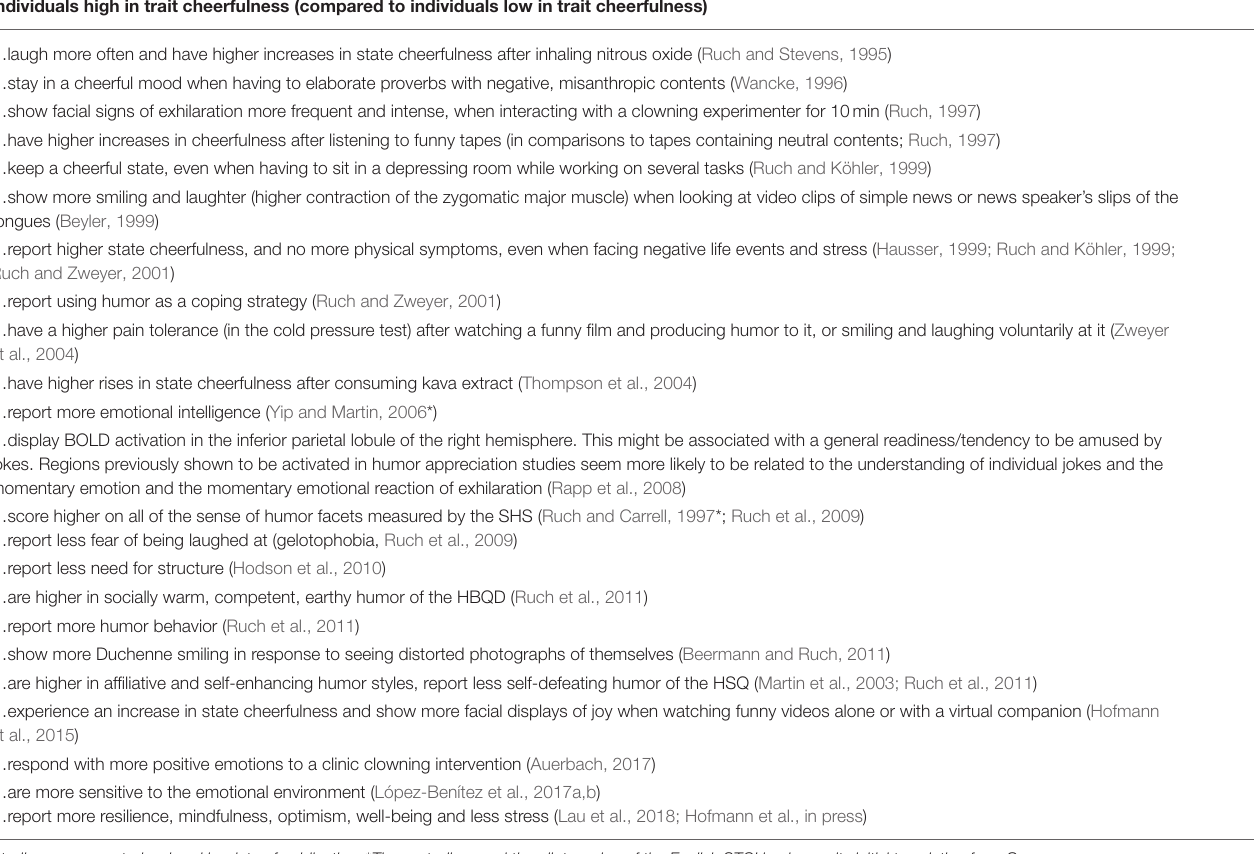
TABLE 2 | State and trait cheerfulness and the experimental induction of amusement and cheerful mood (adapted from Ruch and Hofmann, 2012). Individuals high in trait cheerfulness (compared to individuals low in trait cheerfulness) …laugh more often and have higher increases in state cheerfulness after inhaling nitrous oxide (Ruch and Stevens, 1995) …stay in a cheerful mood when having to elaborate proverbs with negative, misanthropic contents (Wancke, 1996) …show facial signs of exhilaration more frequent and intense, when interacting with a clowning experimenter for 10min (Ruch, 1997) …have higher increases in cheerfulness after listening to funny tapes (in comparisons to tapes containing neutral contents; Ruch, 1997) …keep a cheerful state, even when having to sit in a depressing room while working on several tasks (Ruch and Köhler, 1999) …show more smiling and laughter (higher contraction of the zygomatic major muscle) when looking at video clips of simple news or news speaker’s slips of the tongues (Beyler, 1999) …report higher state cheerfulness, and no more physical symptoms, even when facing negative life events and stress (Hausser, 1999; Ruch and Köhler, 1999; Ruch and Zweyer, 2001) …report using humor as a coping strategy (Ruch and Zweyer, 2001) …have a higher pain tolerance (in the cold pressure test) after watching a funny film and producing humor to it, or smiling and laughing voluntarily at it (Zweyer et al., 2004) …have higher rises in state cheerfulness after consuming kava extract (Thompson et al., 2004) …report more emotional intelligence (Yip and Martin, 2006*) …display BOLD activation in the inferior parietal lobule of the right hemisphere. This might be associated with a general readiness/tendency to be amused by jokes. Regions previously shown to be activated in humor appreciation studies seem more likely to be related to the understanding of individual jokes and the momentary emotion and the momentary emotional reaction of exhilaration (Rapp et al., 2008) …score higher on all of the sense of humor facets measured by the SHS (Ruch and Carrell, 1997*; Ruch et al., 2009) …report less fear of being laughed at (gelotophobia, Ruch et al.,